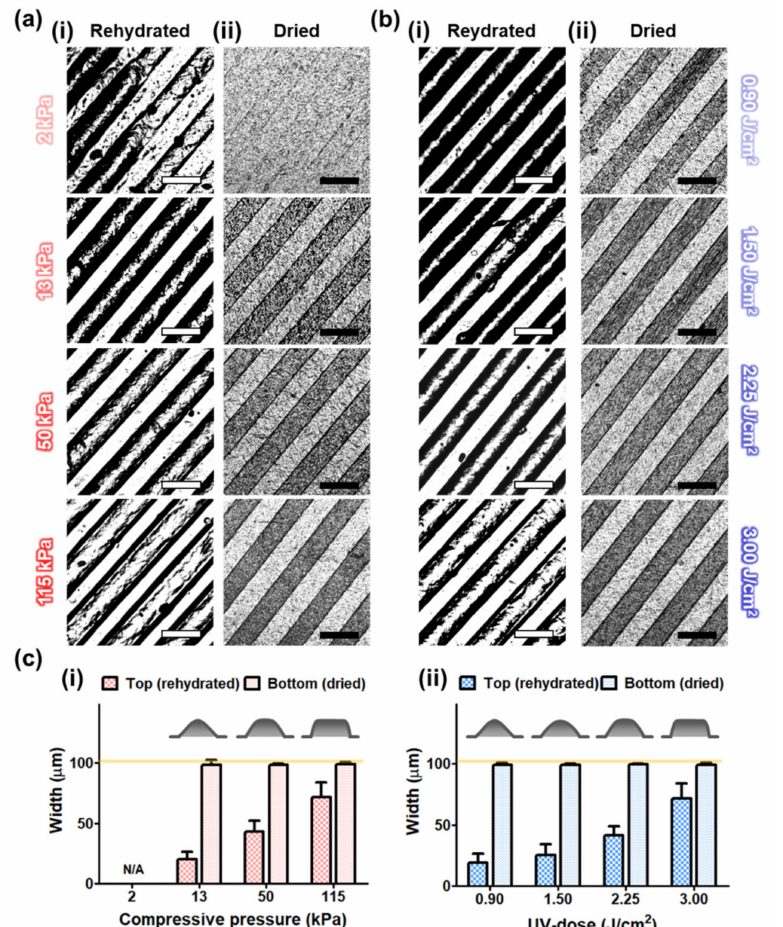
Figure 2. E ff ects of processing parameters on micro-ridge patterns. Microscopic images of the IPC-CE constructs for ( a ) di ff erent compressive pressures at the same UV dose of 3.00 J / cm 2 and ( b ) di ff erent UV doses at same compressive pressure of 115 kPa in ( i ) rehydrated and ( ii ) dried state. All scale bars are 200 µ m. ( c ) Quantitative measurement of micro-ridge pattern width for rehydrated and dried IPC-CE construct according to ( i ) compressive pressure and ( ii )